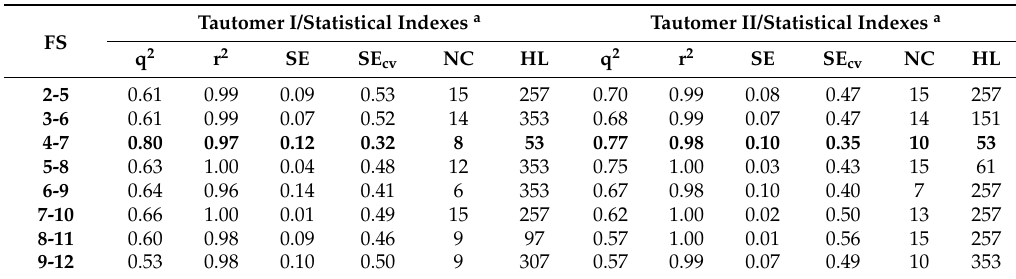
Table 4. Summary of hologram quantitative structure–activity relationship (HQSAR) statistical indexes for the influence of various fragment sizes (FS) using the fragment distinction (FD) parameters atoms and connections (A/C) for both tautomers I (amino) and II (imino) data sets.